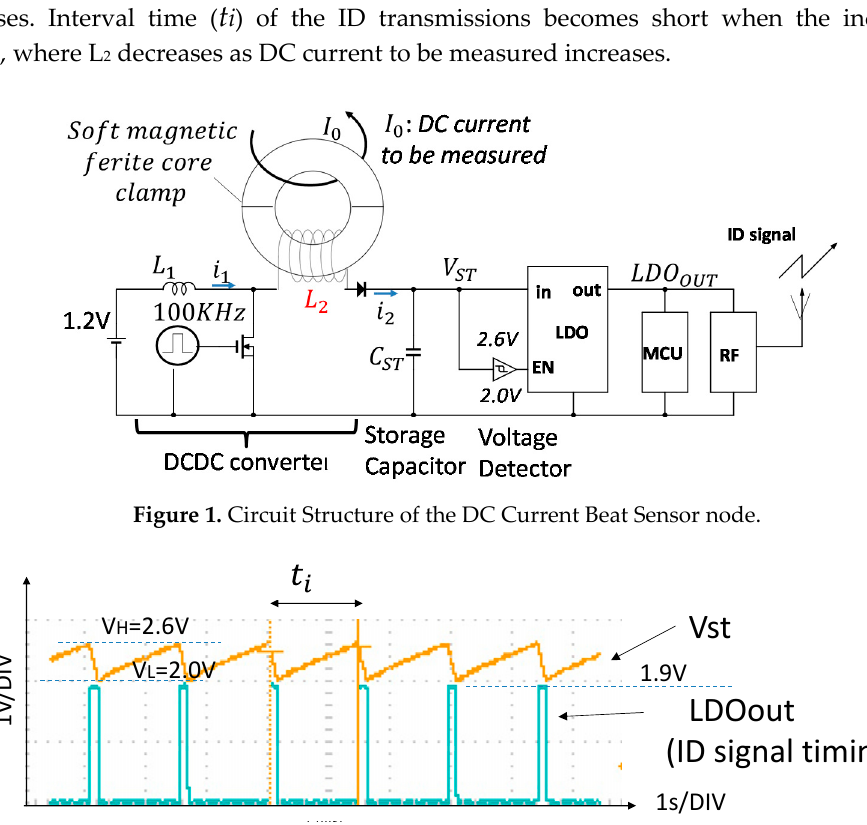
Figure 2. Vst and LDOout waveforms by DC Current Beat Sensors.